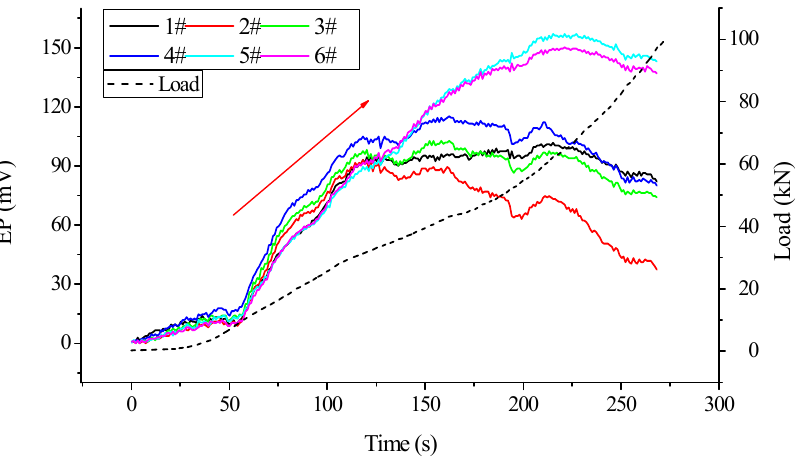
Figure 9. Experimental results of EP response on the concrete specimen under uniaxial compression.